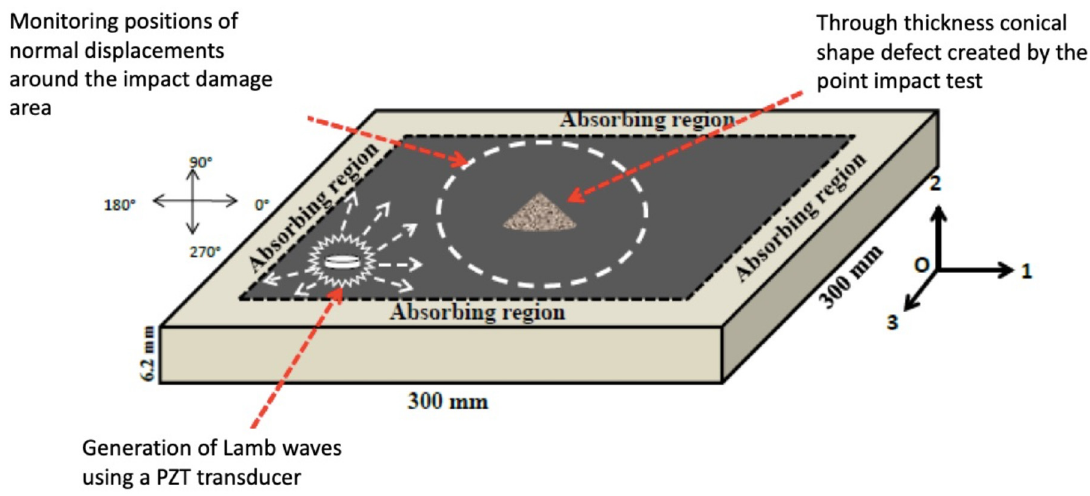
Figure 5. Schematic of the 3D-finite element model.